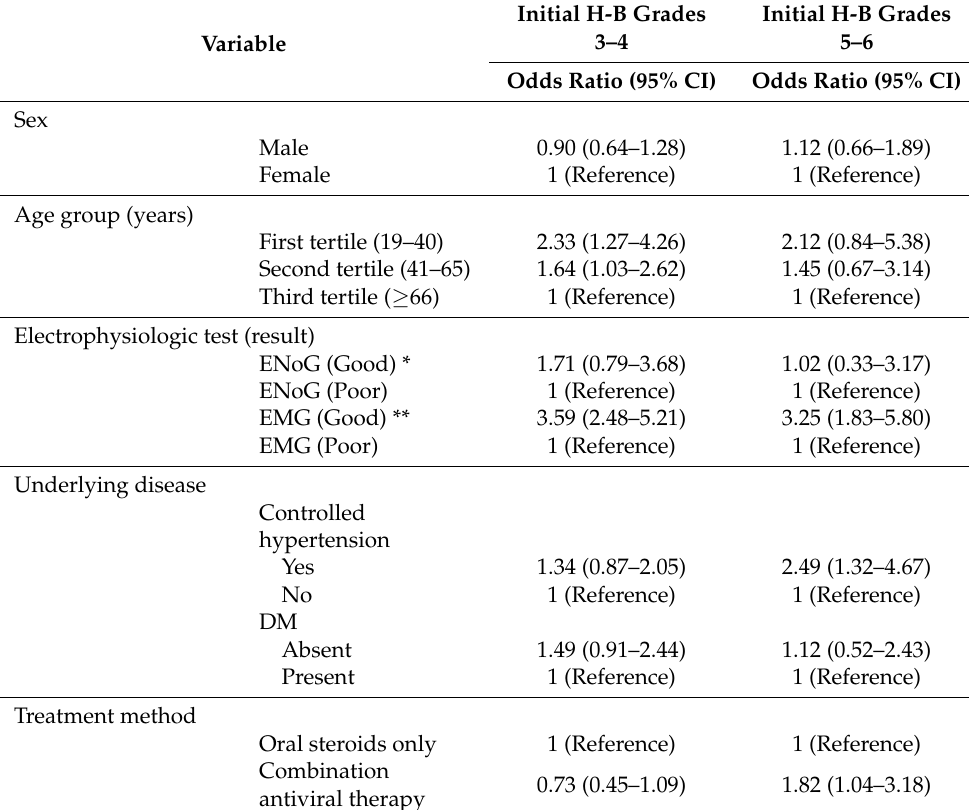
Table 2. Results of multivariable logistic regression analysis of favorable outcome stratified by initial H-B